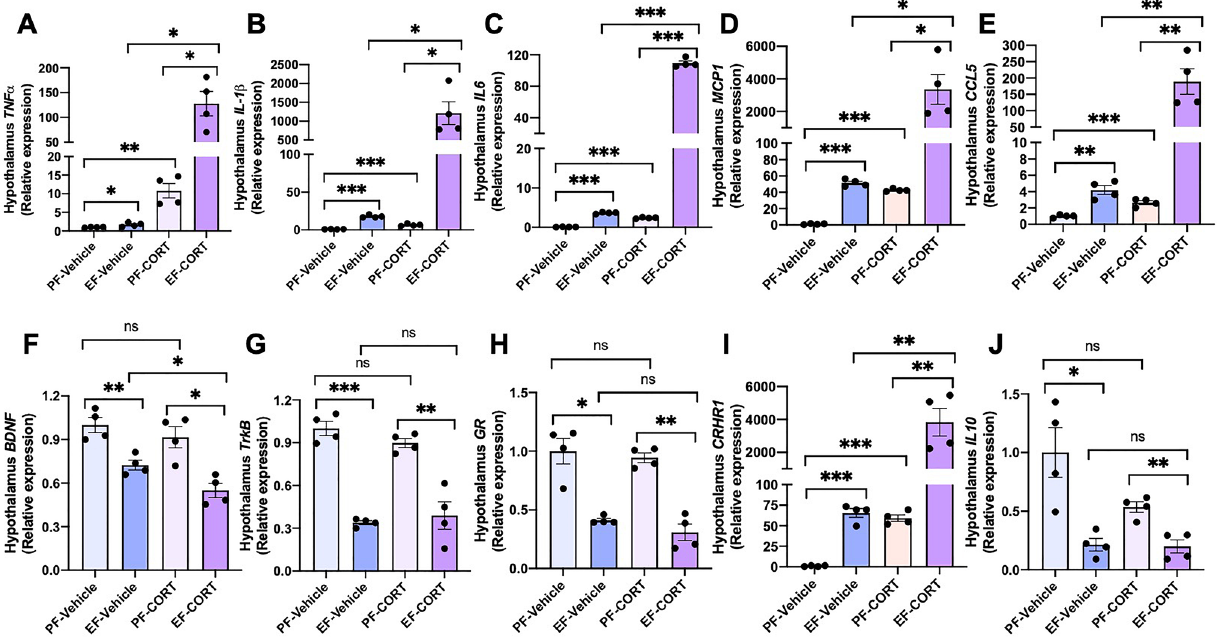
Figure 5. Corticosterone synergizes alcohol-induced neuroinflammation. Adult mice were fed a liquid diet with (EF) or without (PF) ethanol for four weeks. In some groups, animals were injected with corticosterone (CORT) daily. Animals in other groups were injected with the vehicle. Inflammatory responses in the hypothalamus were assessed by measuring specific mRNA for TNFα ( A ), IL-1β ( B ), IL-6 ( C ), MCP1 ( D ), CCL5 ( E ), BDNF ( F ), TrkB ( G ), GR ( H ), CRHR1 ( I ), and IL-10 ( J ). Values in graphs are mean ± SEM (n = 4). Dots in bars indicate individual values. The numbers above the bars are p -values for differences between the groups indicated by the horizontal lines, and "ns" indicates no significant difference between